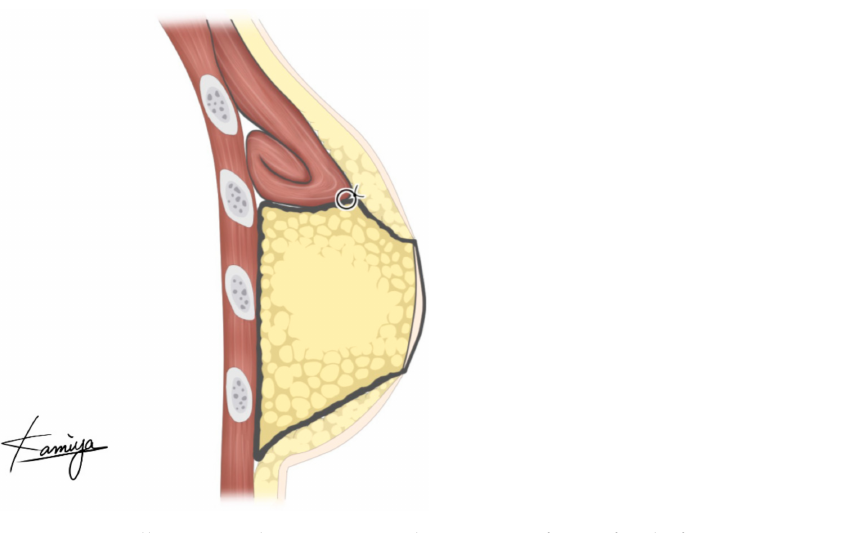
Figure 1. An illustration demonstrating the concept of a profunda femoris artery perforator flap breast reconstruction augmented with the pectoralis major muscle flap.